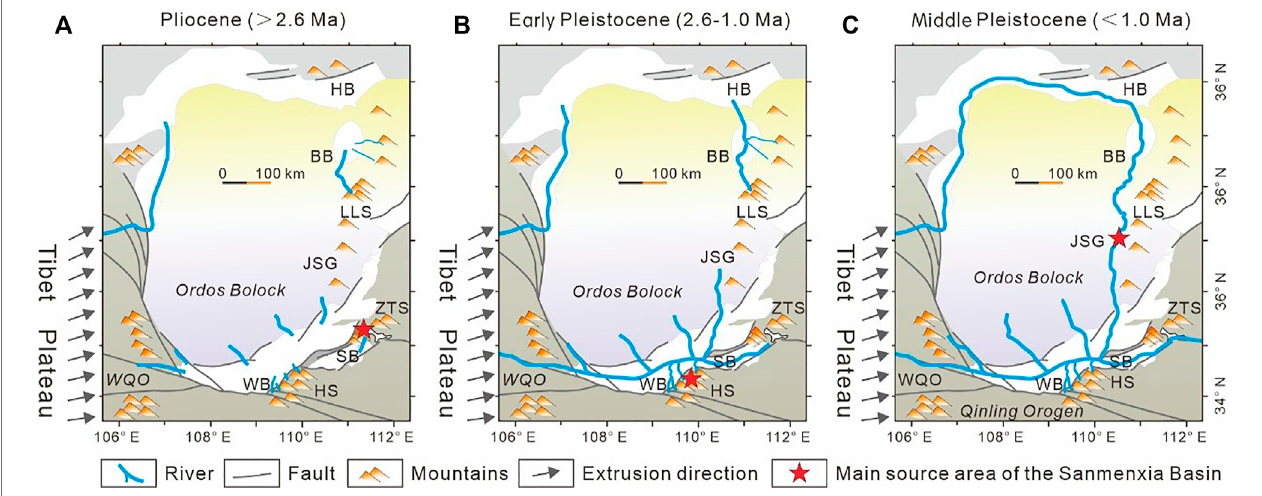
FIGURE4| SketchmapsillustratingformationprocessesofthemiddlereachoftheYellowRiver. (A) Shortriversdevelopedsurroundinglocallakesduringtheearly Pliocene. (B) Regional drainage started to connect during Early Pleistocene. (C) Modern Yellow River fi nally formatted at ∼ 1.0 Ma. HB: Hetao Basin; BB: Baode Basin; LLS: Lvliang Mountain; JSG: Jinshaan Gorge; WQO: West Qinling Orogen; WB: Weihe Basin; SB: Sanmenxia Basin; HS: Hua Mountain; ZTS: Zhongtiao Mountain.